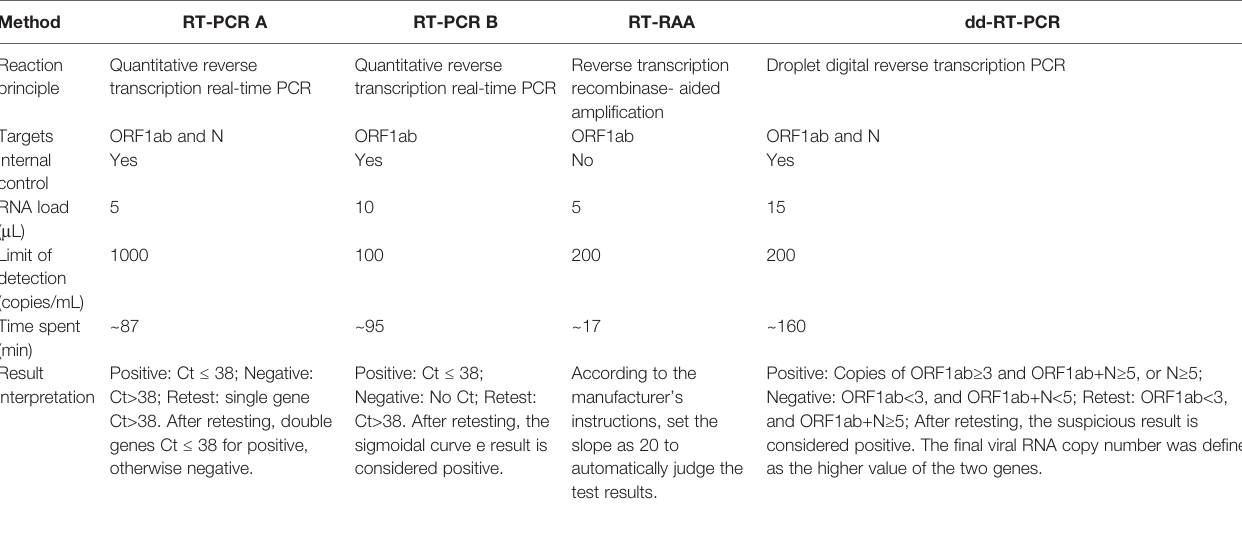
TABLE 1 | Introduction of the 4